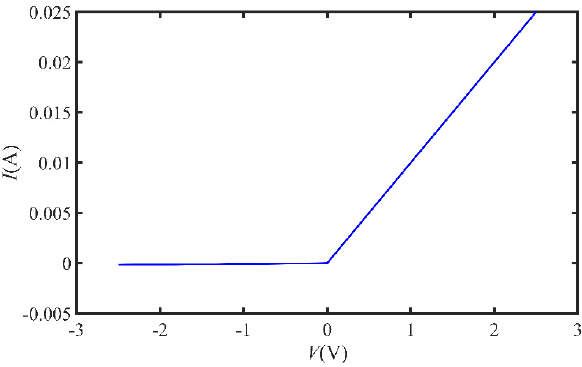
Figure 3. DC response of the HP TiO 2 memristor.